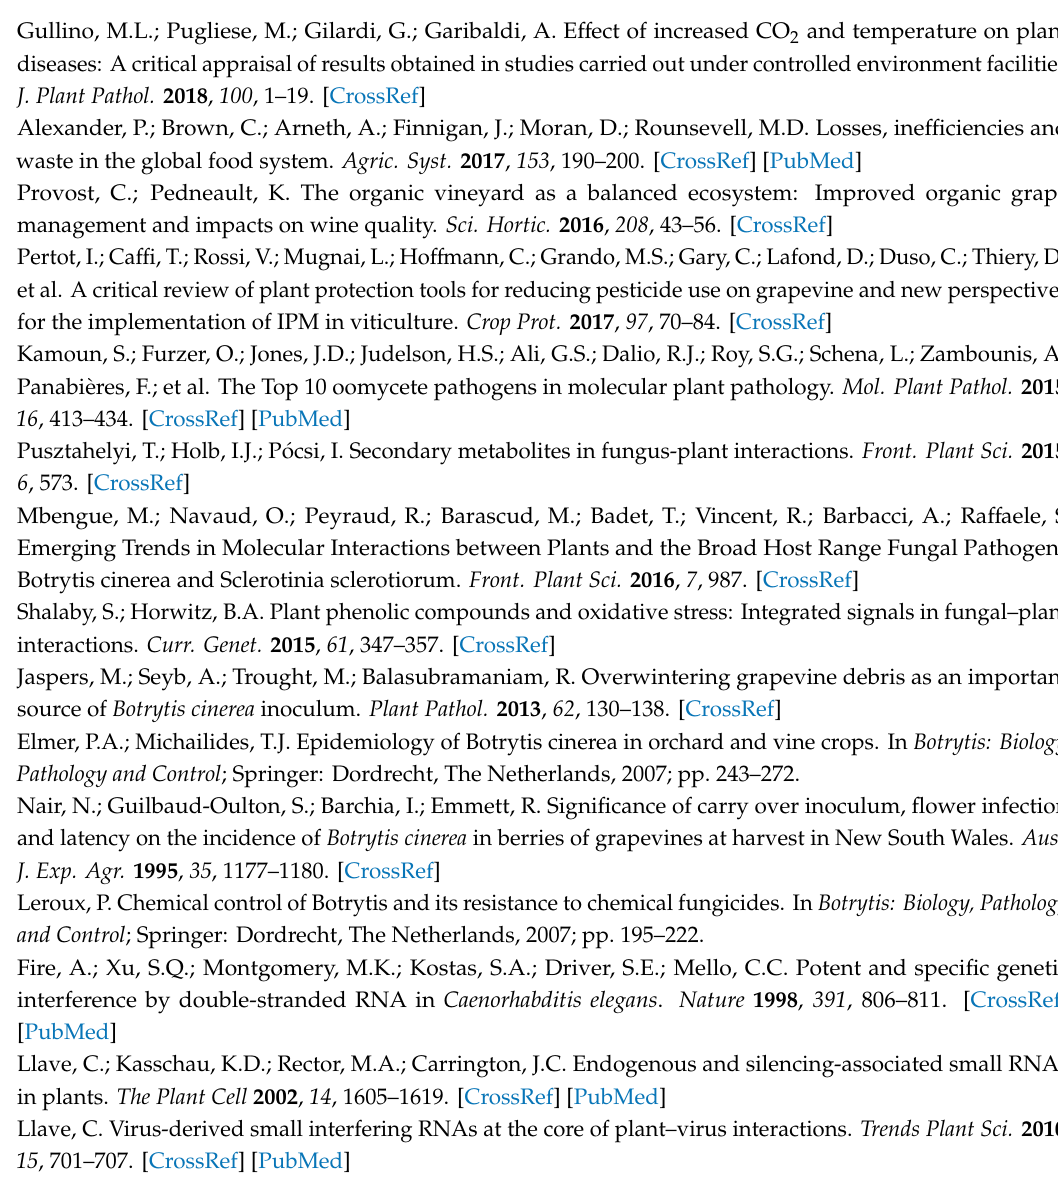
Table S1: List of primer, Figure S1: Agarose gel electrophoretic analysis of dsRNAs, Figure S2: Overview of in vivo petiole adsorption, Figure S3: Northern blot